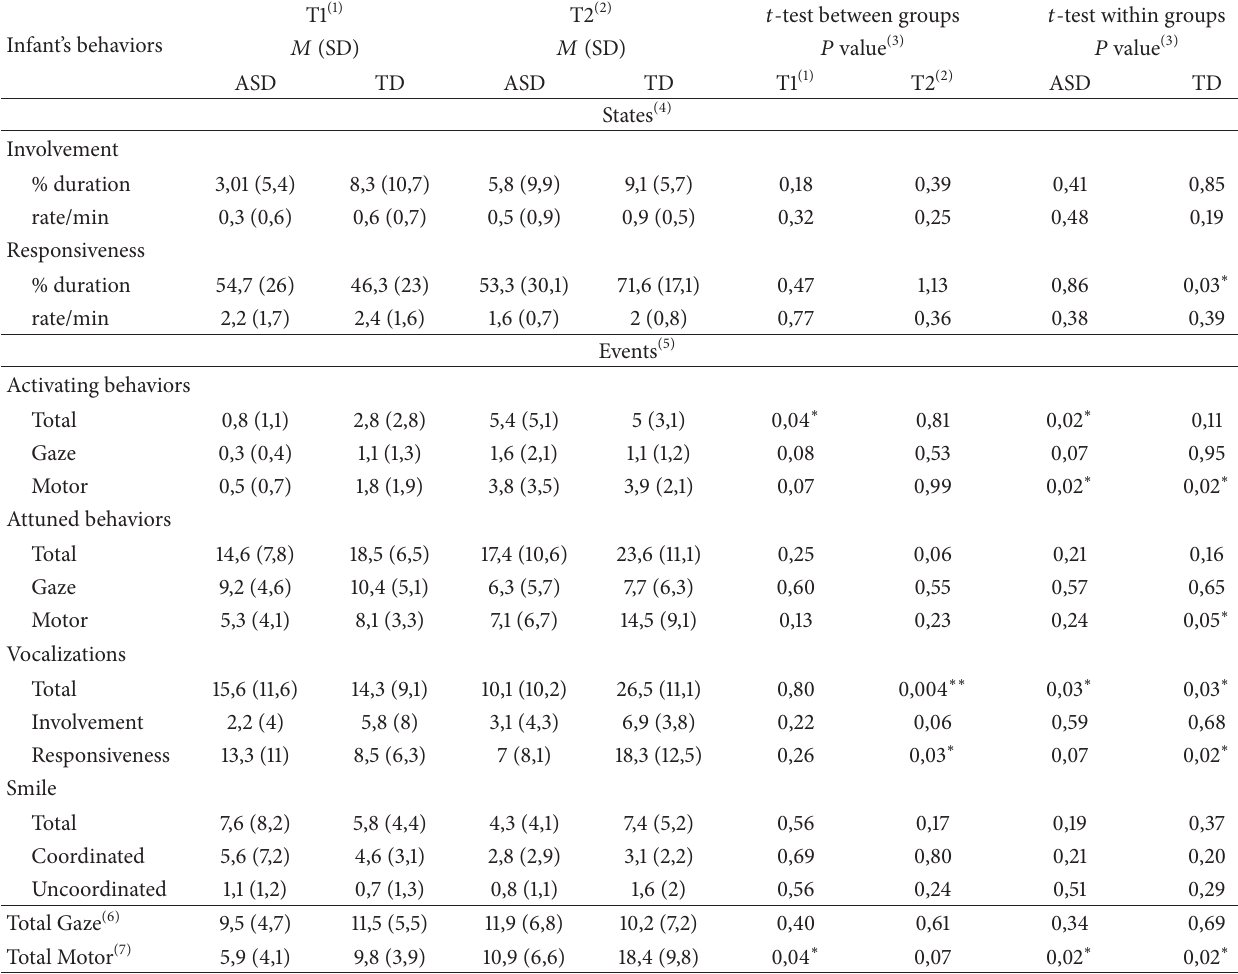
Table 2: Infant’s behaviors: means and standard deviations for ASD and TD. 𝑡 -test between groups at T1 and T2 and within groups in ASD and TD.